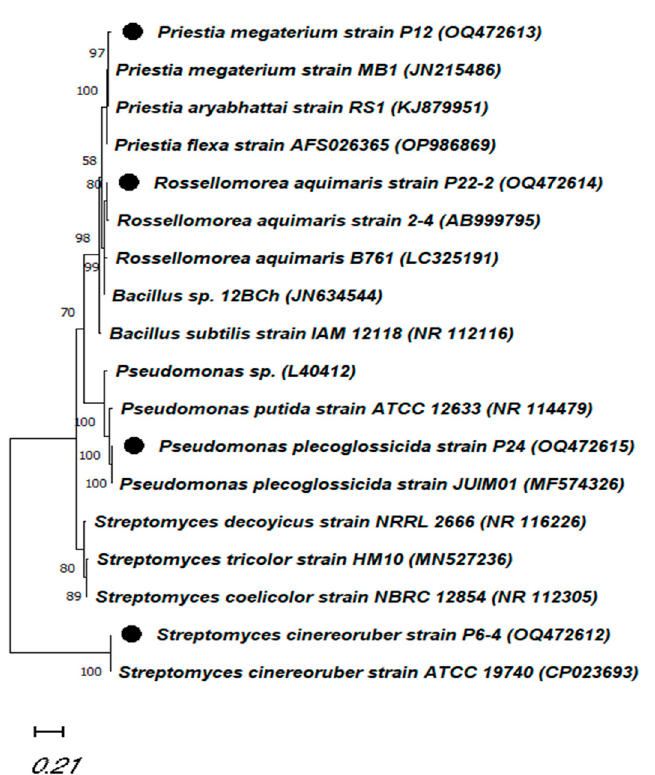
Figure 5. The constructed molecular phylogenetic tree inferred by using the maximum-likelihood method and Tamura-Nei model with 18 nucleotide sequences. ● points to our strains under study.